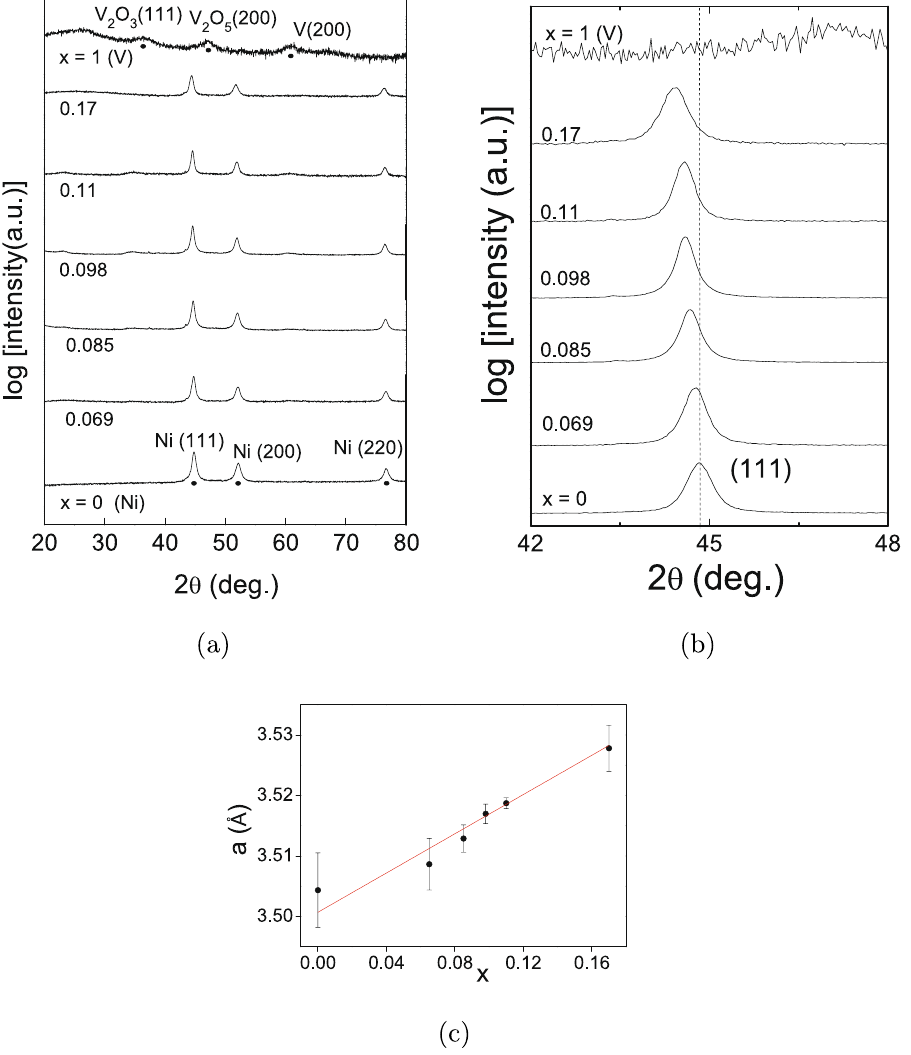
Figure 3. ( a ) XRD patterns of Ni 1 − x V x samples. Details are explained in the main text. ( b ) Magnified view of the XRD patterns around (111) peak. The dotted vertical line is for reference. ( c ) Variation of lattice constant a with composition x